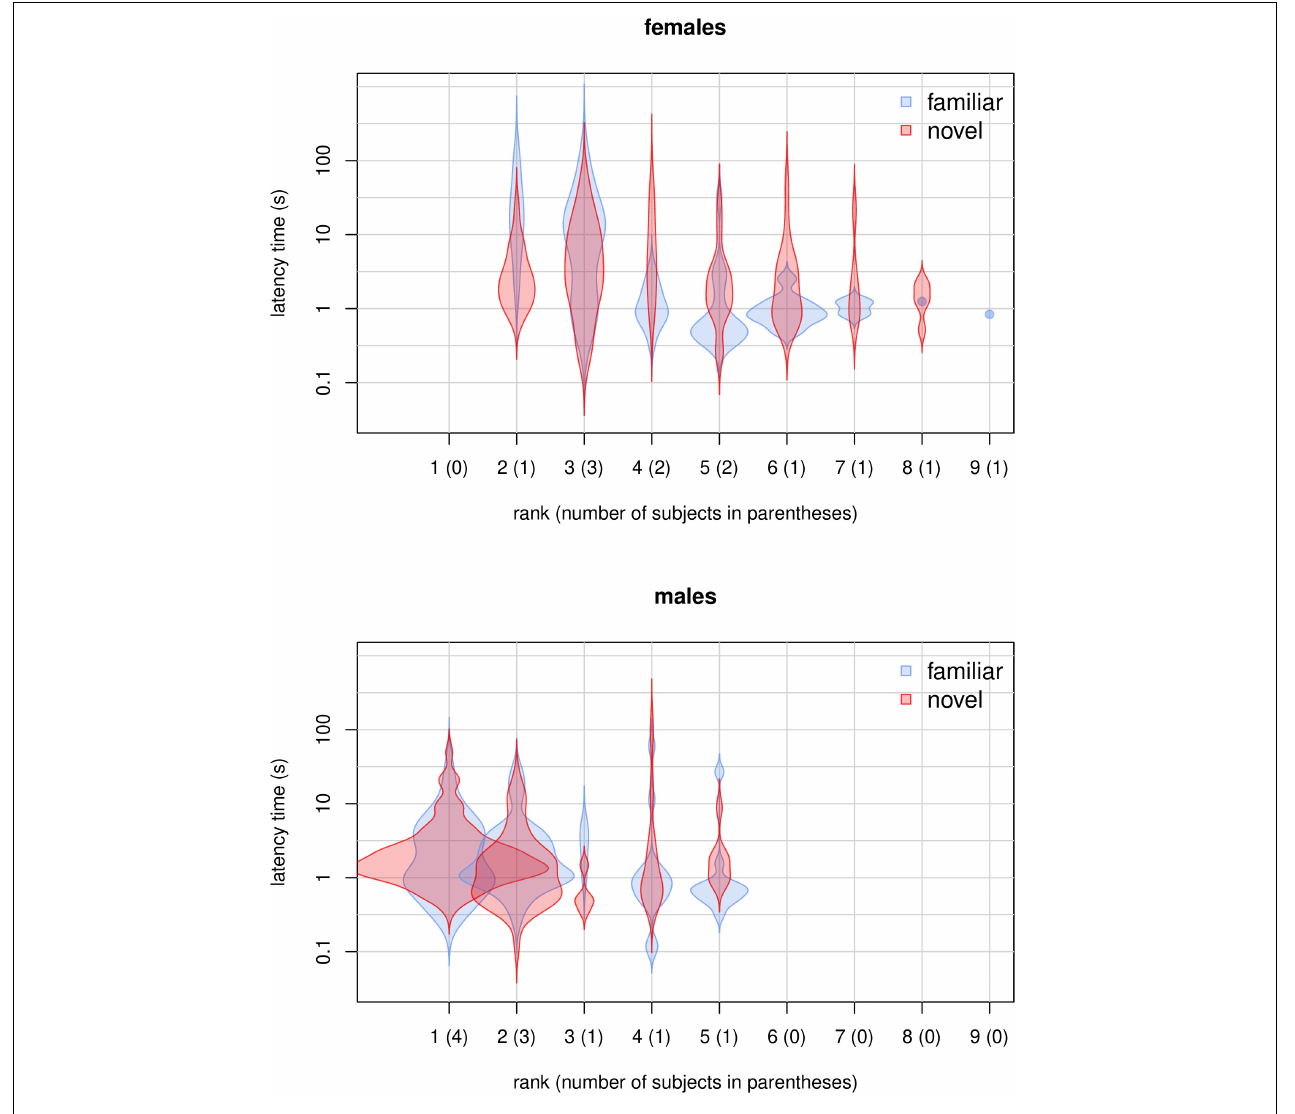
FIGURE 3 | Violin plots showing the distribution of latency times for novel and familiar food items for each rank and